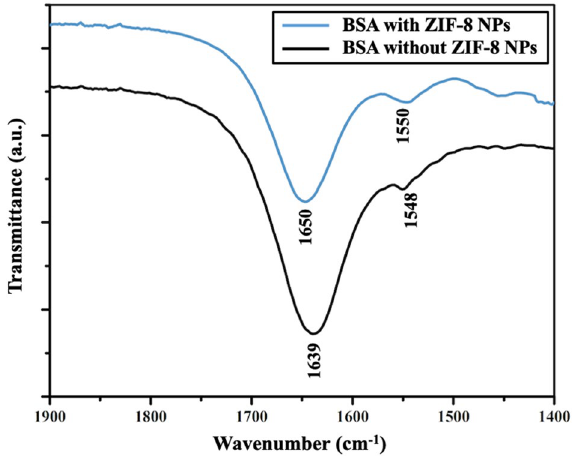
Figure 7. FT-IR spectra of BSA showing changes in amide-I and amide-II bands upon interaction with ZIF-8 NPs.